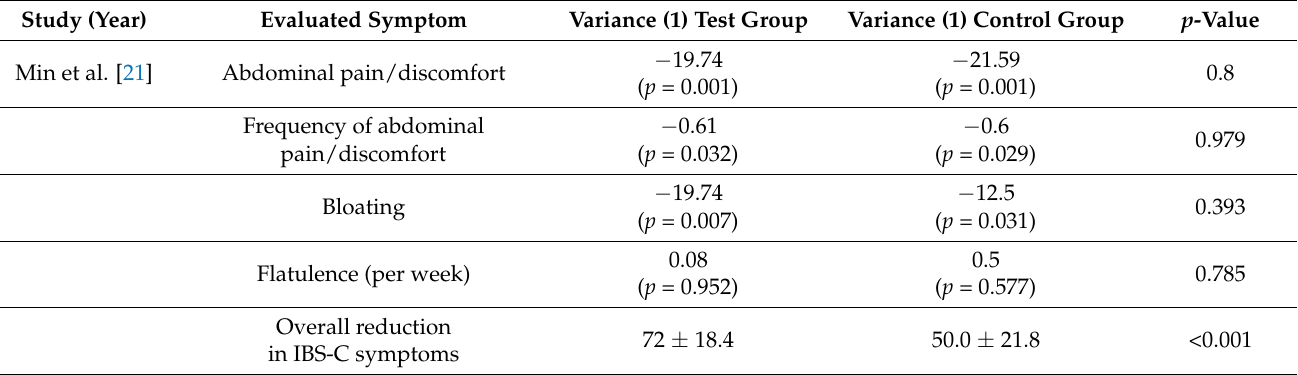
Table 5. Abdominal symptoms outcomes for patients suffering from